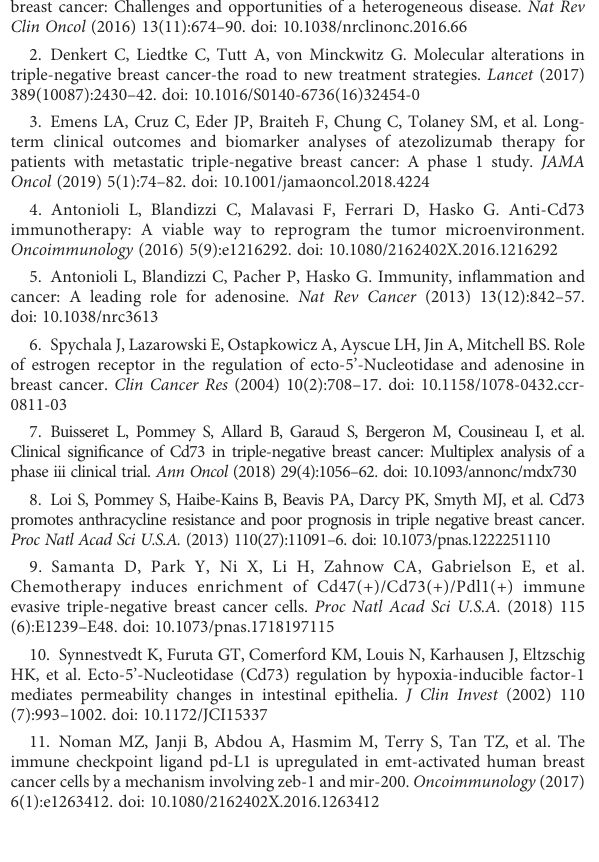
FIGURE S1 Epithelial and mesenchymal protein expression in MDA-MB-468 and MDA-MB-231 cells. Representative Western-blot analysis of three independent experiments showing protein levels of ZEB1, Vimentin, and E-cadherin in MDA-MB-468 vs. MDA-MB-231 cells. Actin was used as a loading control. FIGURE S2 Expression of SNAI1 and CD73 mRNA in MDA-MB-468 cells treated with increasing doses of Dox. (A) RT-qPCR measurements of SNAI1 and CD73 mRNA using increasing doses of Dox, n=4. *P < 0.05 by Mann Whitney. Means ± SEM are shown. (B) Representative FACS contour plot of three independent experiments showing intra-cellular SNAI1 and surface CD73 staining in MDA-MB-468 iSNAI1 displaying EPI, EMT, and MET phenotype conditions. (C) Expression of epithelial and EMT markers (E-Cadherin, SNAIL1, ZEB1, N-Cadherin and Vimentin) in epithelial-like Py-230 and mesenchymal-like Py-8119 cells. Actin was loaded as a control. (D) The expression of full length (FL) and deleted (Del) forms of SNAIL1 in Py-8119 cells transfected with control (CTRL) or SNAIL1 (SNAIL1) CRISPR plasmids. Actin was loaded as a control. (E) RT- qPCR measurement of Nt5e mRNA in Py-8119 described in D. Nt5e expression was calculated relative to control cells expressing FL SNAIL1. Bars represent mean from four independent experiments ± SD; *P < 0.05 calculated by Mann Whitney. (F) Flow cytometry analysis of cell surface CD73 in cells described in D. Left panel: Delta mean fl uorescence intensity (MFI); middle panel: percentage of CD73-